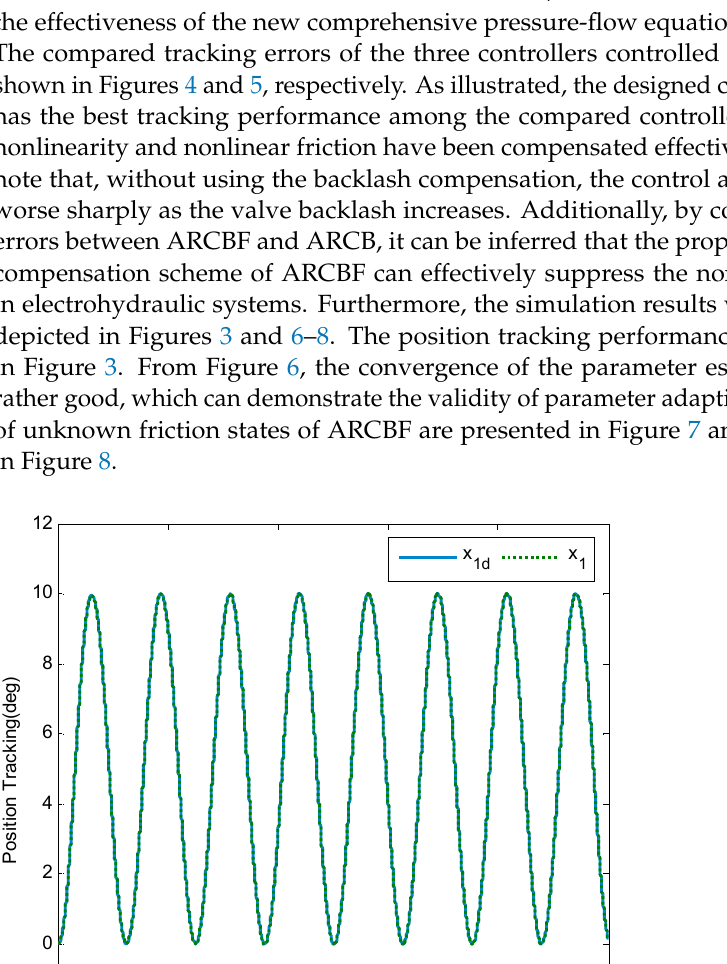
Figure 4. The compared tracking errors of the three controllers as ε = 1 × 10 − 6 .